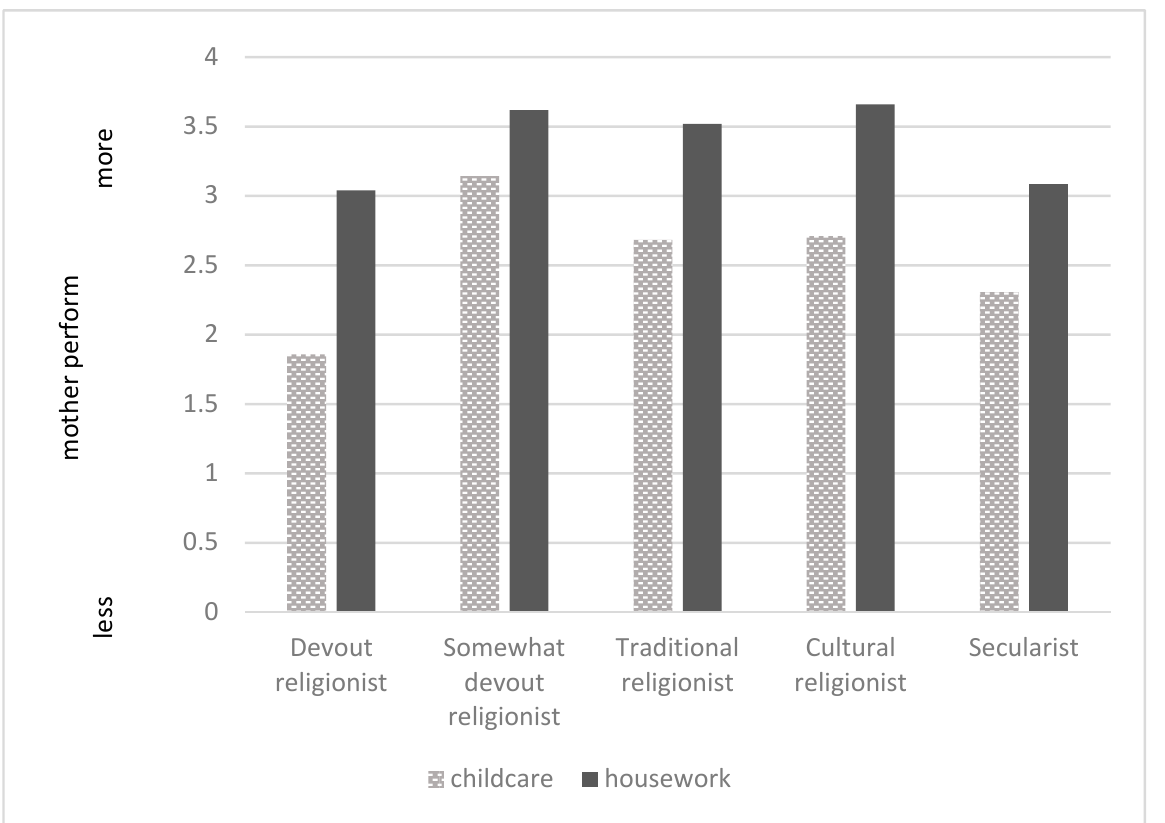
Figure 1. Housework and childcare by religiosity, mean values. Source: Families and Inequalities Survey,